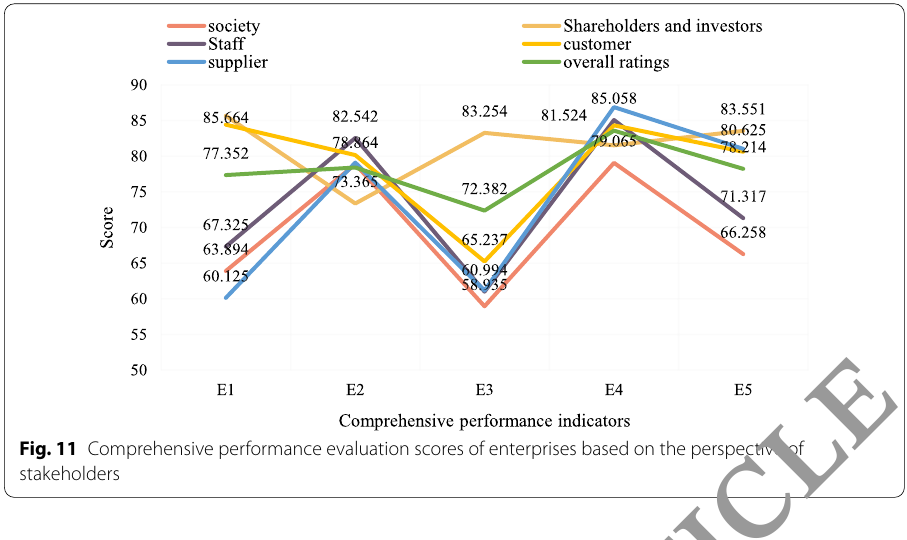
Fig. 11 Comprehensive performance evaluation scores of enterprises based on the perspective of